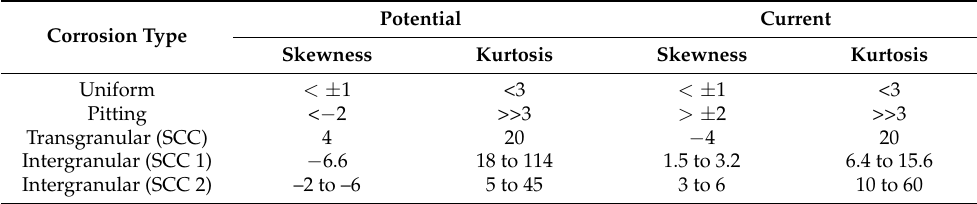
Table 4. Types of corrosion as a function of skewness and kurtosis values.